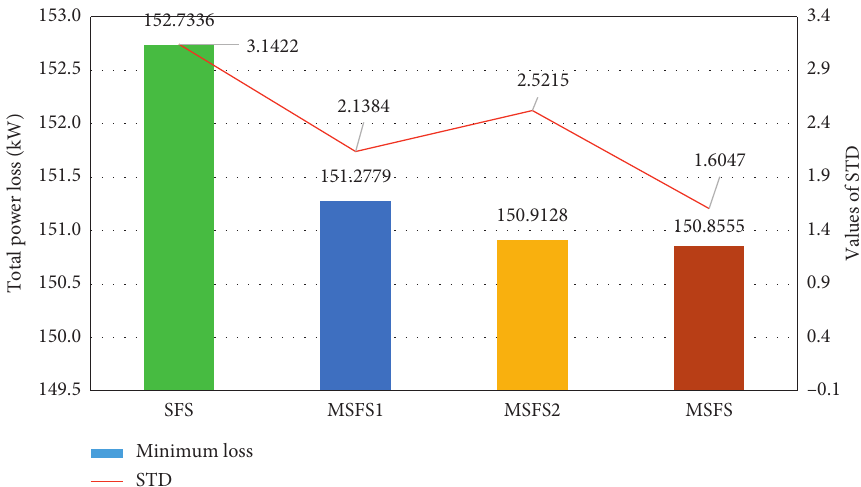
Figure 22: Minimum power loss and standard deviation of 50 trial runs obtained by SFS methods for case 2 of the 85-bus system.